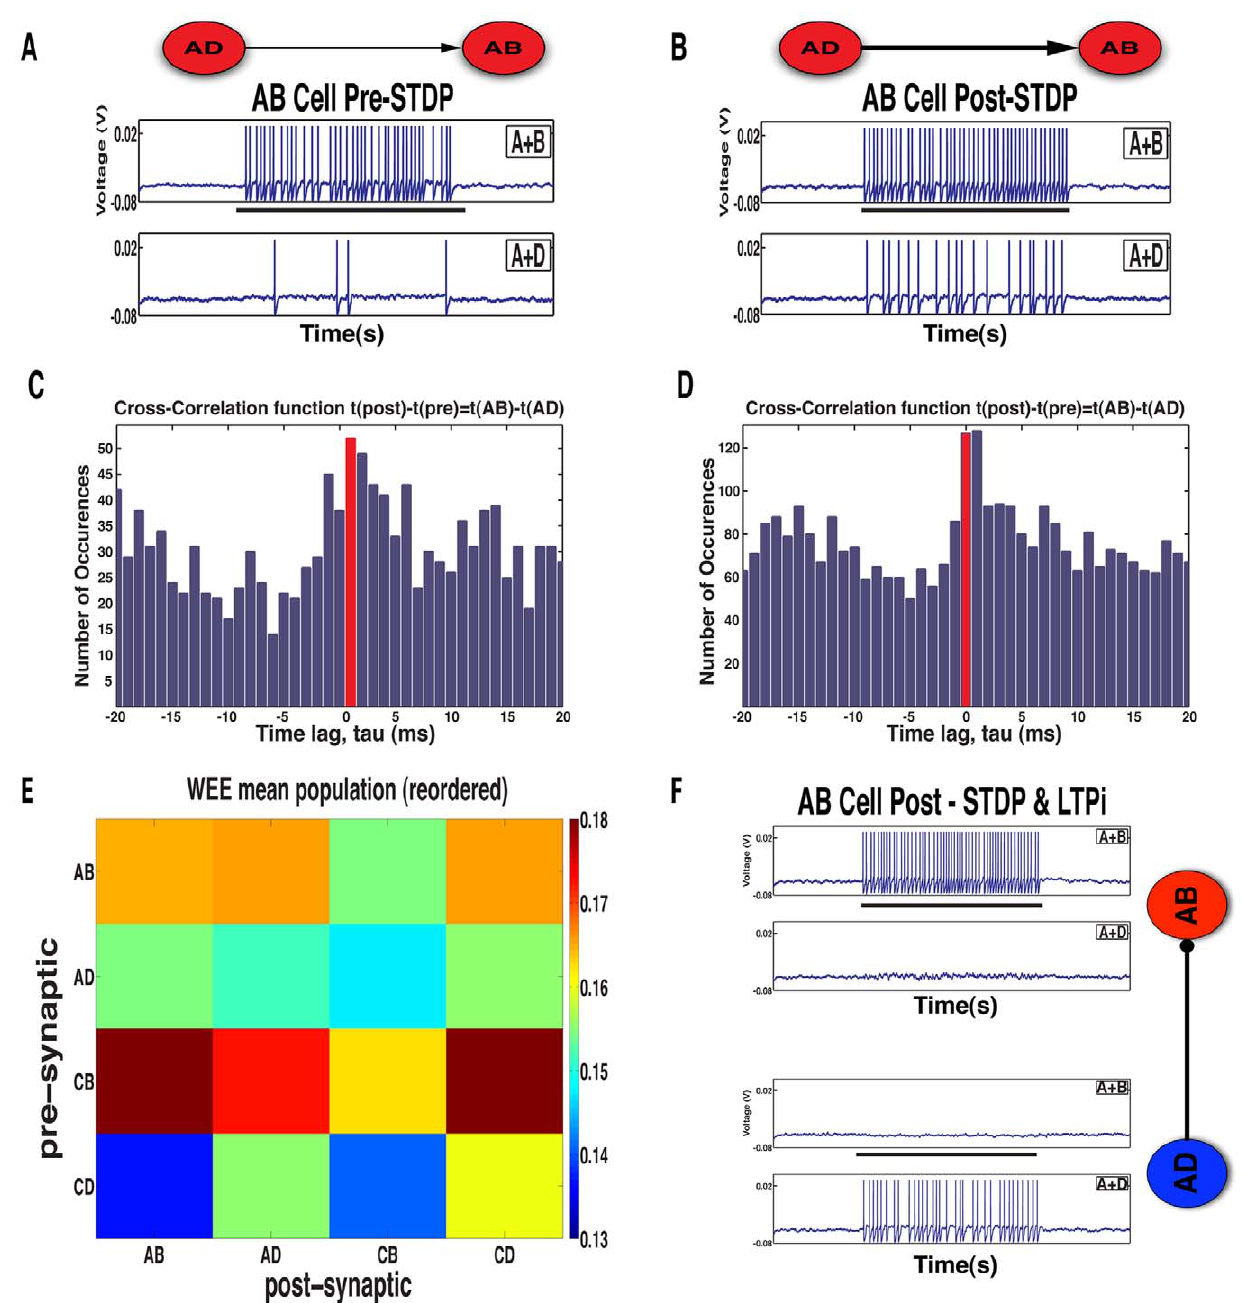
Figure 5. STDP over-associates. A–B . The voltage trace of a postsynaptic AB selective neuron (selectivity index=2.22 before training) is shown in A before training the network with standard STDP. Following training with STDP the postsynaptic AB neuron, B , is now responsive to stimulus AD as well, reducing its selectivity (to a value of 1.77). C and D show the cross-correlation function between a presynaptic AD selective neuron and the postsynaptic AB selective neuron shown in A–B during the initial and final AD trials after standard STDP. Following training with standard STDP the synapse from the AD cell to the AB cell potentiates, as seen in the cross-correlation function by looking at the shift in the distribution from right to left of time lag t =0 (red bar) in the initial (C) to final (D) histograms. E . The net change in mean population recurrent excitatory weights demonstrates undesirable strengthening between multiple different stimulus-pair responsive populations, for example the AD-to-AB mean synaptic strength is greater than the recurrent AD-to-AD synaptic strength (network with 10 inputs per group with connection probability of 1/2). F . Standard STDP training with LTPi added eliminates the AB neuron’s response to stimulus A + D due to strengthening of the presynaptic AD inhibitory synapse, illustrated on the right. In a final set of networks we repeated our main simulations Recurrent inhibitory feedback produced no qualitative differenc- with the addition of recurrent inhibition via 25% random es in our main results, as networks with LTPi showed the same connectivity from excitatory to inhibitory cells (Figure S8). improvement over networks without LTPi. Recurrent inhibition